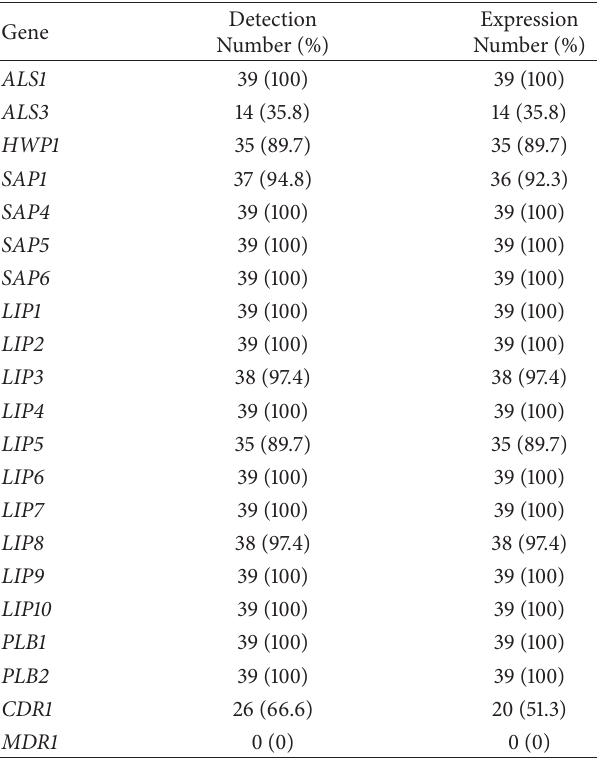
Table 4: Percentages of detection and expression of virulence markers and azole resistance genes in Candida albicans